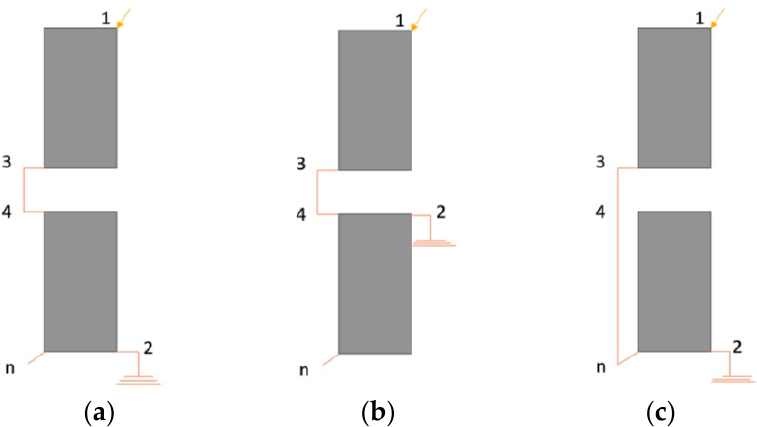
Figure 4. Transformer HV lightning impulse: ( a ) maximum tap; ( b ) nominal tap—concordant; ( c ) nominal tap—discordant.